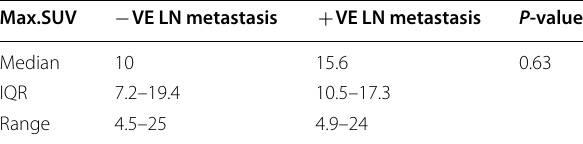
SD standard deviation, IQR interquartile rang, LN lymph nodes Table 4 Comparison of max.SUV in patients with and without distant metastasis Max.SUV